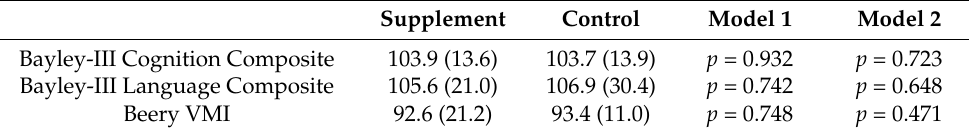
Table 4. Effect of ARA and DHA supplementation on developmental scores at age 24